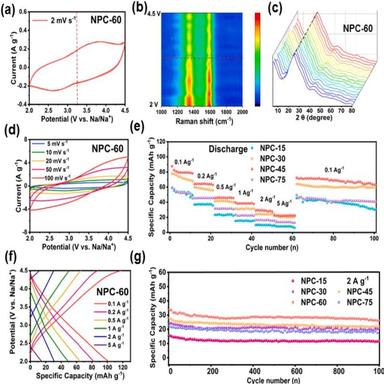
Electrochemical evaluation and ex-tests of the NPCs cathodes. a) The CV curve of NPC-60 at 2 mV s − 1 . b) ex-situ Raman patterns of NPC-60 electrodes at 2–4.5 V. c) ex-XRD patterns of NPC-60 electrodes at 2–4.5 V. d) The CV curves of NPC-60 in the range of 5–100 mV s − 1 . e) Rate performances of the NPCs electrodes in the range of 0.1–5 A g− 1 . f) Charge/discharge profiles of NPCs at different current densities. g) Long cycling stability of NPCs at 2 A g− 1 .